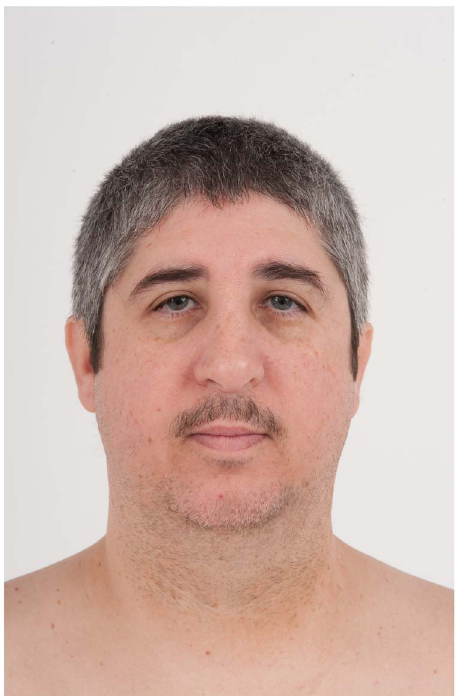
Figure 2. Profile view of Patient 1 at age 41 years. Dysmorphic features include a low posterior hairline, small ( ,2 2 standard deviation), low-set ears and a high nasal bridge.